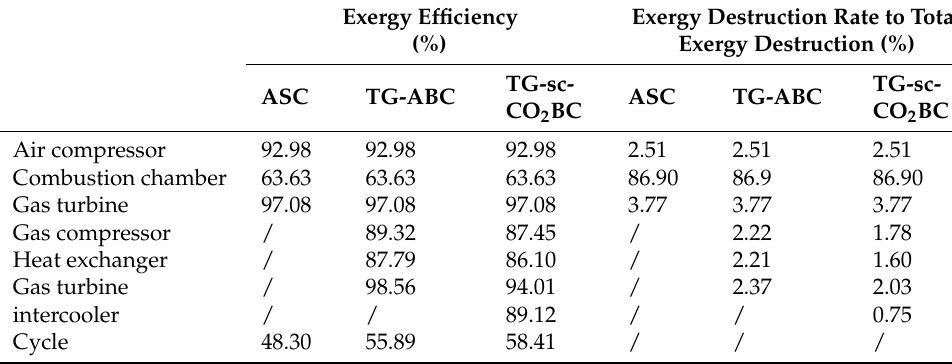
Table 14. Component exergy efficiency and exergy destruction rate to total exergy destruction with the three cycles for plant